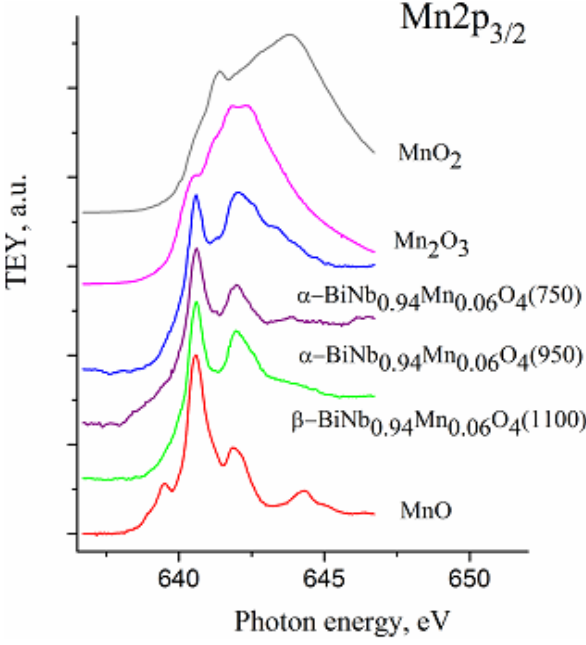
Figure 6: NEXAFS Mn2p–spectra of the manganese-containing solid solutions BiNb 0.94 Mn 0.06 O 4− δ synthetized at the temperature of 950 ∘ C, 1100 ∘ C, 750 ∘ C and manganese oxides MnO, Mn 2 O 3 and MnO 2